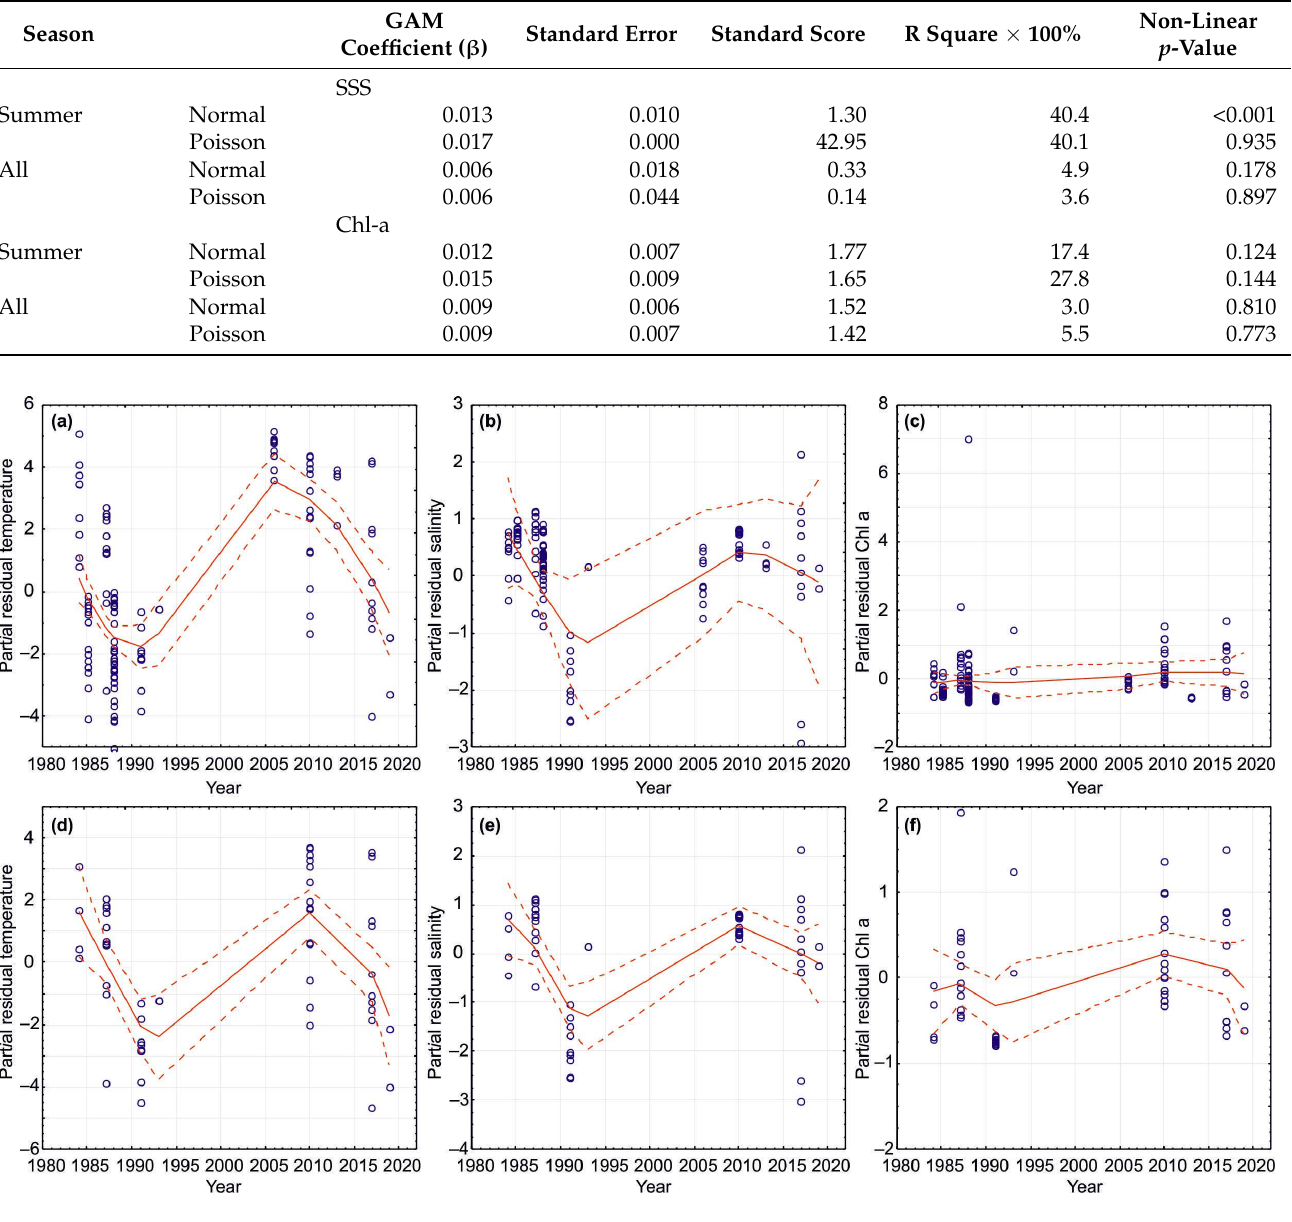
Figure 8. GAM results (parametric, normal added functions) for SST, SSS, and Chl ‐ a as response variables in relation to year as explanatory variable at the Kola Section (Barents Sea, 69°30 ′ –74°30 ′ N, 33°30 ′ N) during the period 1984–2021. ( a – c )—all data combined; ( d – f )—summer data.